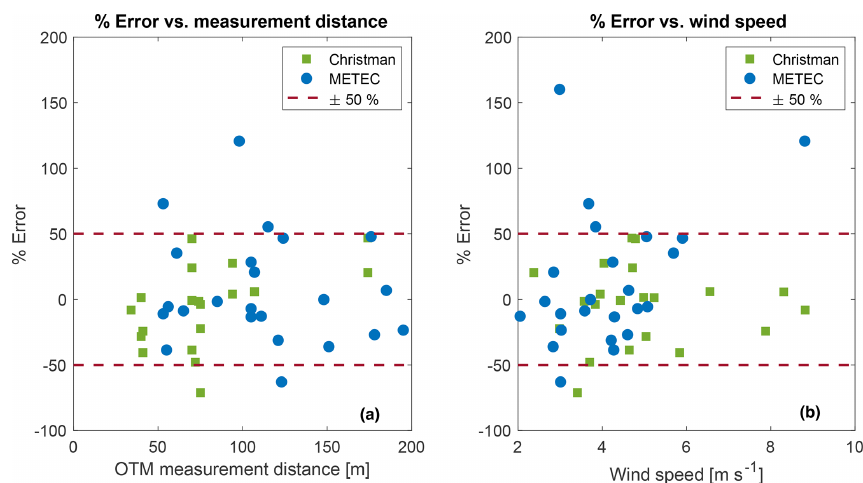
Figure 10. OTM 33A percent error compared to the measurement distance (a) . OTM 33A percent error compared to the mean measurement wind speed (b) . Positive percent error is OTM overestimating the known release.